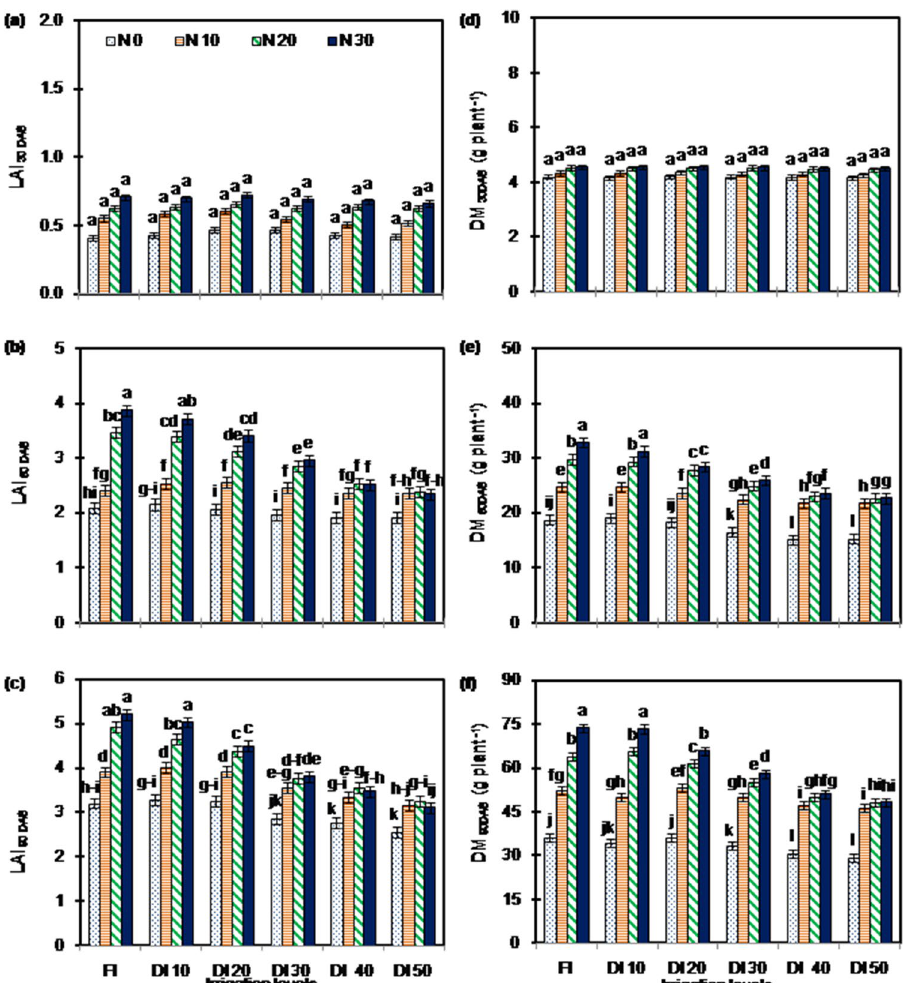
Figure 2. Leaf area index at ( a ) 30 DAS, ( b ) 60 DAS, ( c ) 90 DAS and dry matter production at ( d ) 30 DAS, ( e ) 60 DAS, ( f ) 90 DAS of peanut under different irrigation and N application rates. [Data points are mean ± standard error, n = 9 (3 × 3; 3 growing seasons and 3 replications per treatment)].Error bars are standard error. Bar followed by different letter/s are significantly different at P < 0.05 level according to LSD. LAI: leaf area index; DM: dry matter production; DAS : days after sowing. The details of treatments are given in Table